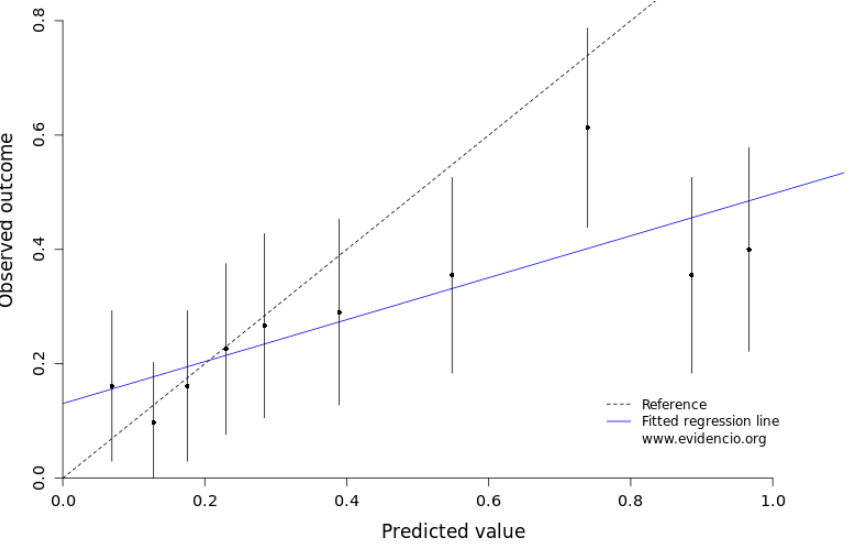
Figure 4. Graphical representation of model calibration, plotting the predicted probability ( x -axis) with corresponding 95% CI against the actually observed occurrence of severe post-operative complications (defined as Clavien–Dindo IIIa or higher) in the validation cohort. The dashed line represents perfect calibration. Points under the line display overestimation, and above the line underestimation of the risk of severe post-operative complications.